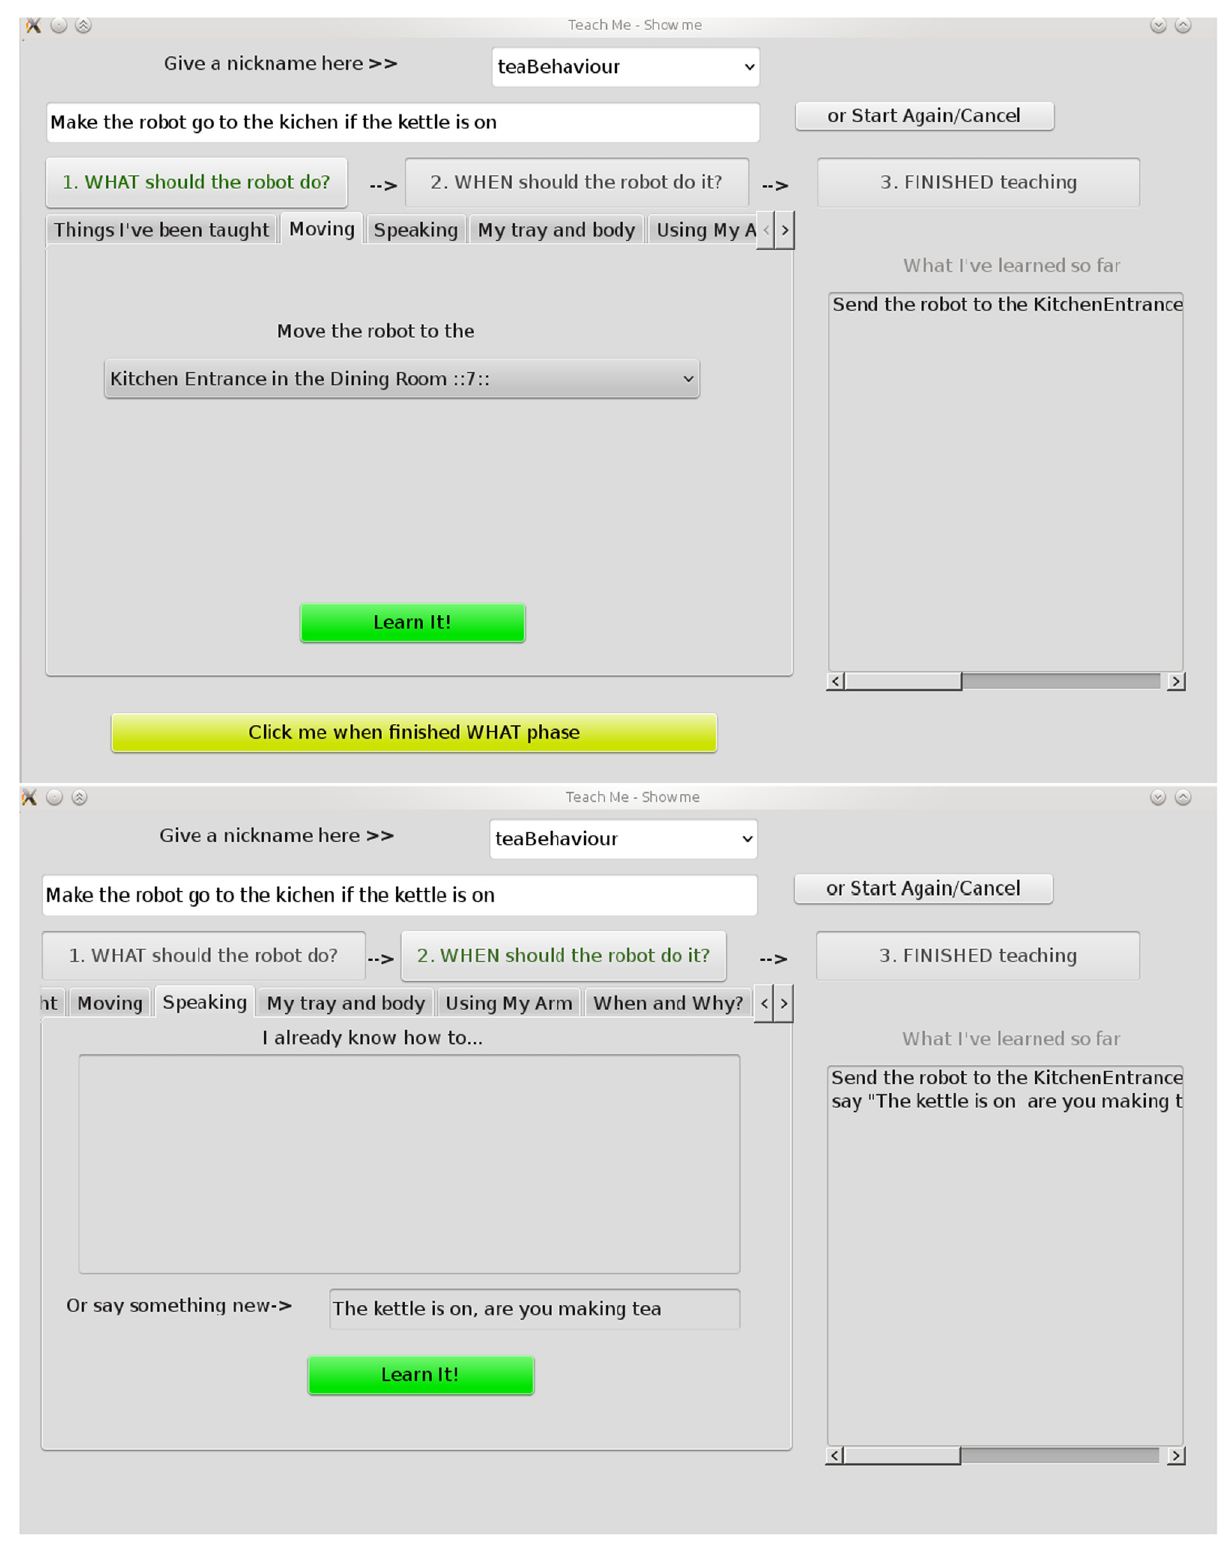
Figure 3: Screenshots of the teaching interface. The “ What ” phase where the user has directed the robot to move to the kitchen and say “ The kettle is on, are you making tea?.